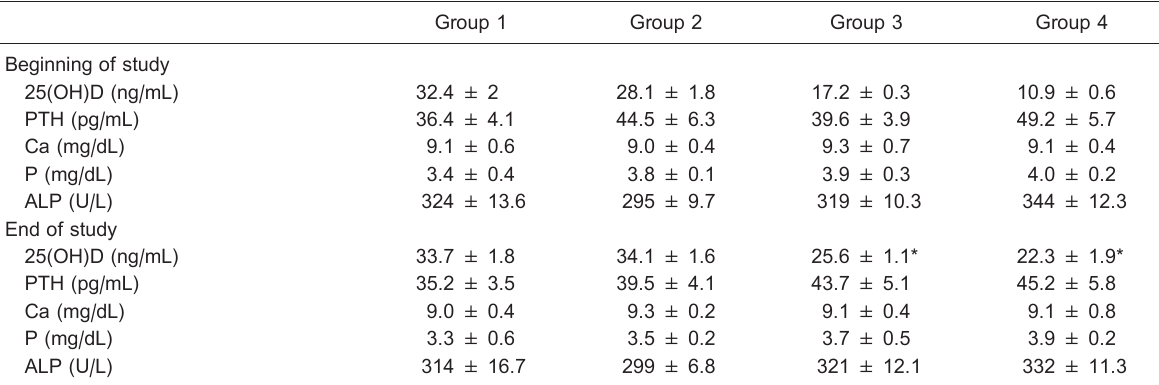
Table 1. Laboratory parameters of all groups at the beginning and end of the 6-month